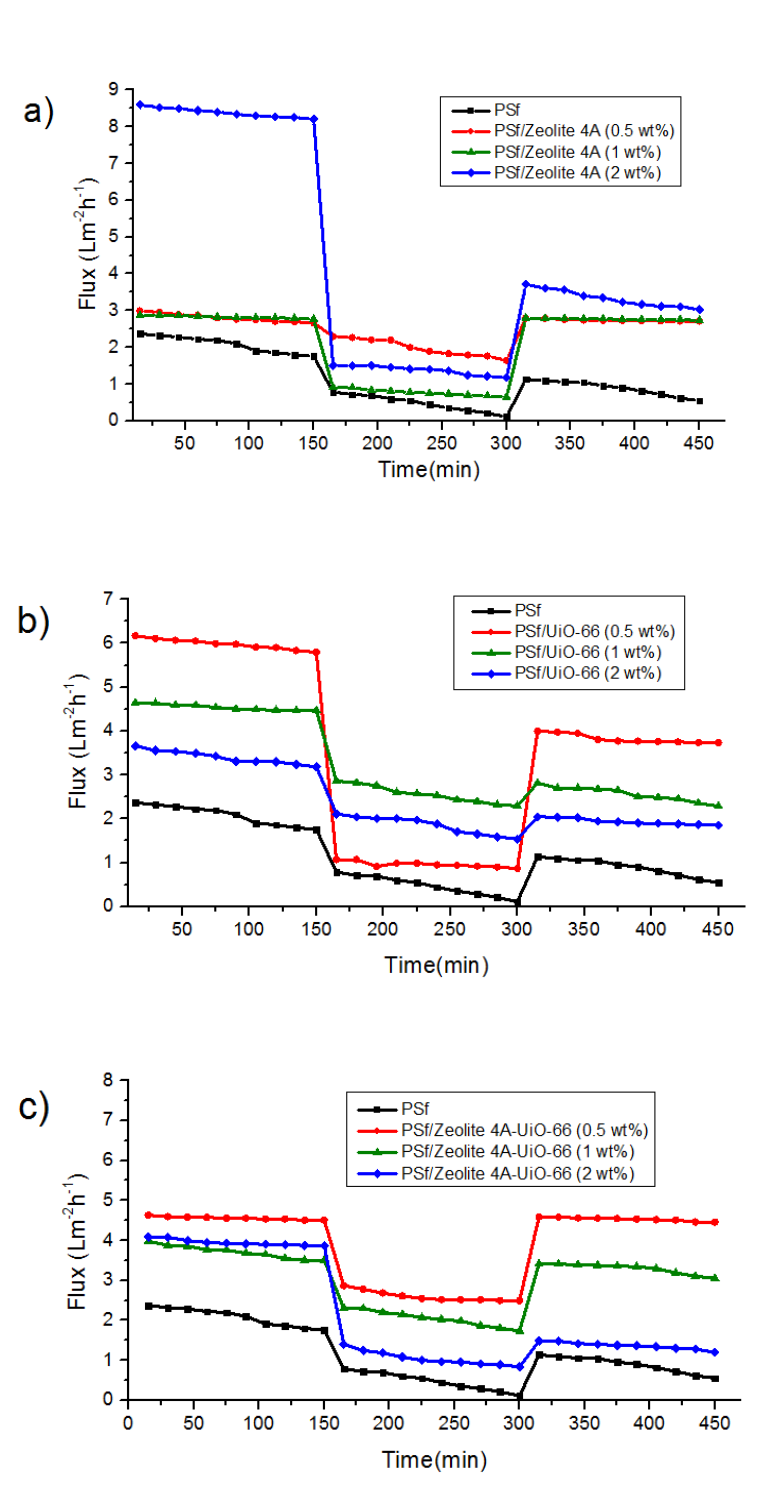
Figure 6. Flux versus time for mixed-matrix PSf membranes with different nanofiller concentrations during three steps: water flux for 150 min, humic acid solution flux for 150 min, and water flux for 150 min after 30 min washing with distilled water ( a ) PSf/Zeolite 4A, ( b ) PSf/UiO-66 and ( c ) PSf/Zeolite 4A-UiO-66.